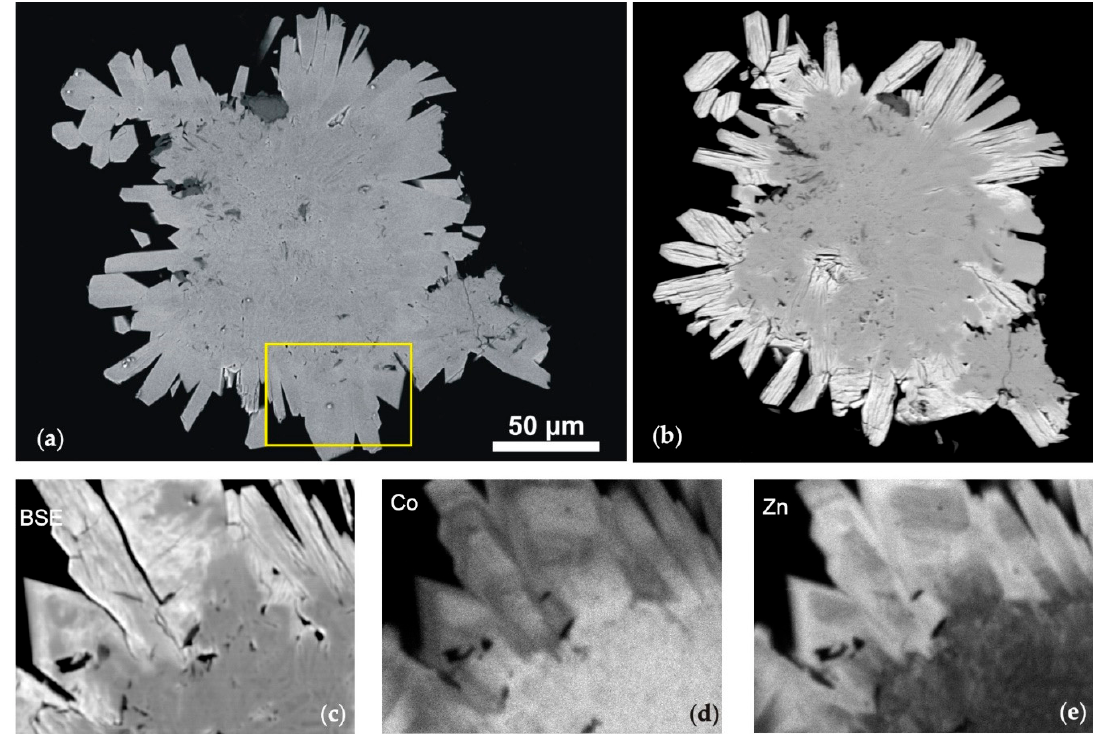
Figure 5. ( a ) BSE image of erythrite overgrown by prismatic crystals of köttigite prior to electron microprobe analysis. Köttigite is only slightly brighter than erythrite due to the greater atomic weight of Zn compared to Co. ( b ) BSE image of ( a ) obtained following electron microprobe analysis and kept for three hours in high vacuum conditions. Köttigite crystals display bright contrast and pronounced (010) cleavage with fractures along cleavage planes not seen in the same crystals in ( a ). Relics of unchanged (lower contrast) köttigite crystals are present in the upper right portion of the image. ( c – e ) BSE image and elemental maps of an area framed in ( a ).